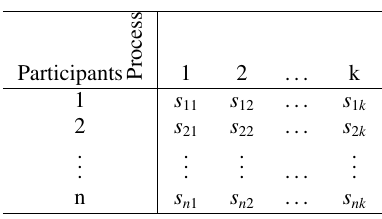
Table 3: Scores given by n participants 5.4.1 Pre-analysis For each of the participants, the scores in